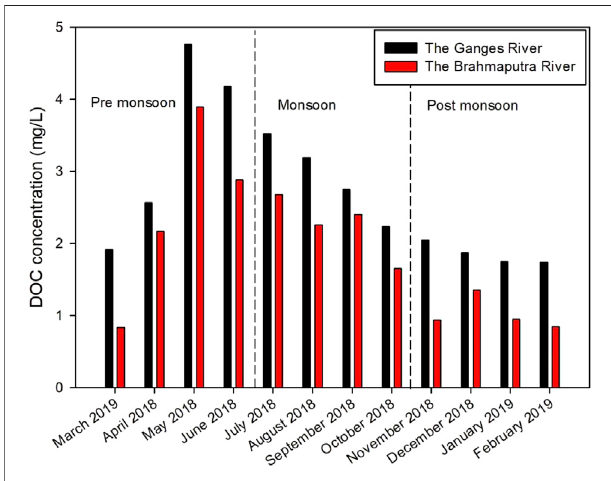
FIGURE 4 | DOC concentration in the downstream of the Ganges and Brahmaputra rivers.